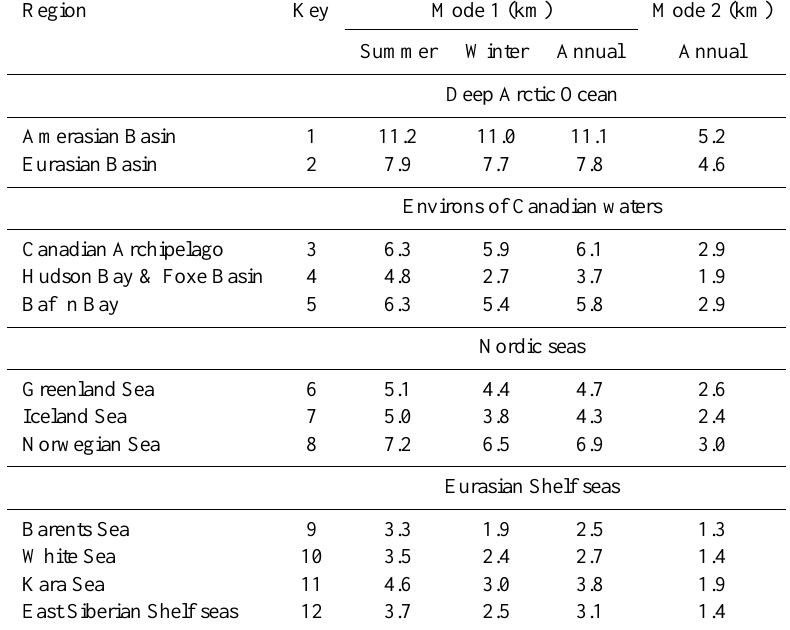
Table 1. Regional averages of Rossby radii mode 1 (summer, winter and annual) and mode 2 (annual). The tabulated regions are shown in Fig. 3, to which the key numbers refer. The Amerasian Basin combines the Canadian and Makarov basins; the Eurasian Basin combines the Amundsen and Nansen basins. Region Key Mode 1 (km) Mode 2 (km) Summer Winter Annual Annual Deep Arctic Ocean Amerasian Basin